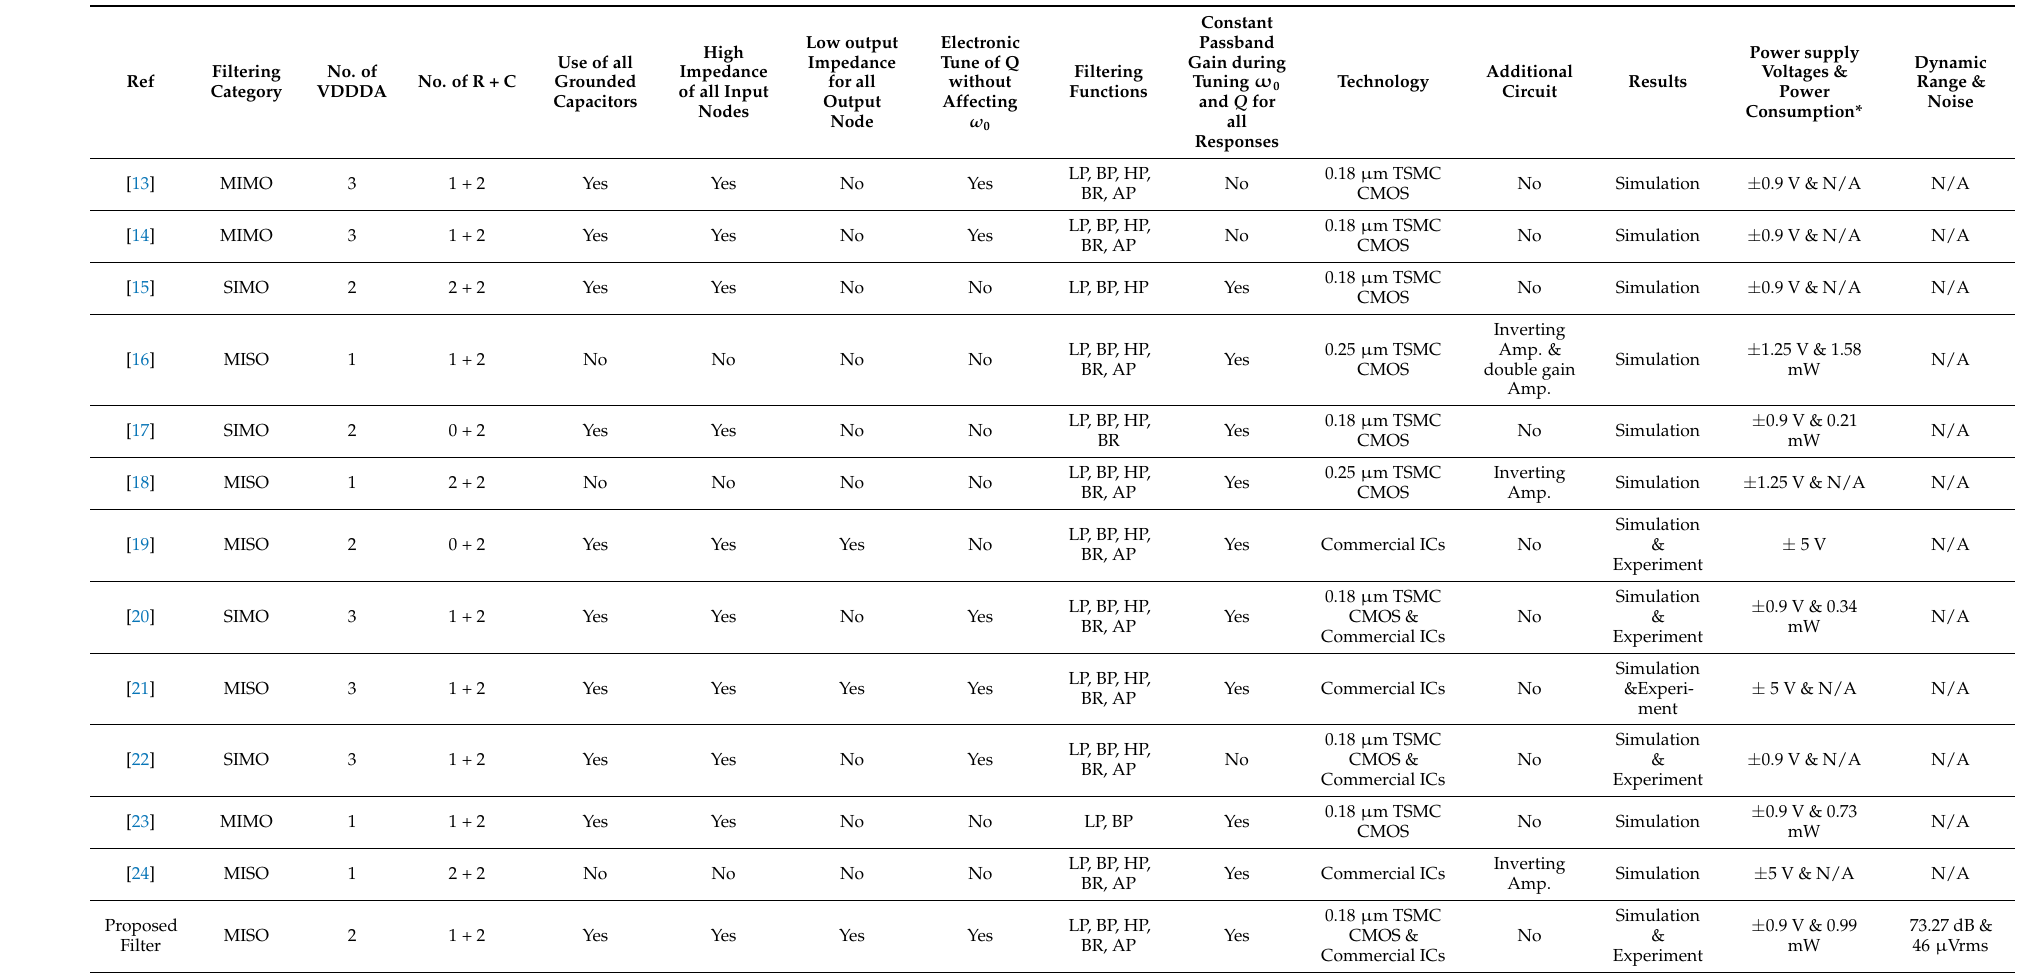
Table 1. Comparison of the proposed biquad filter and other filters using